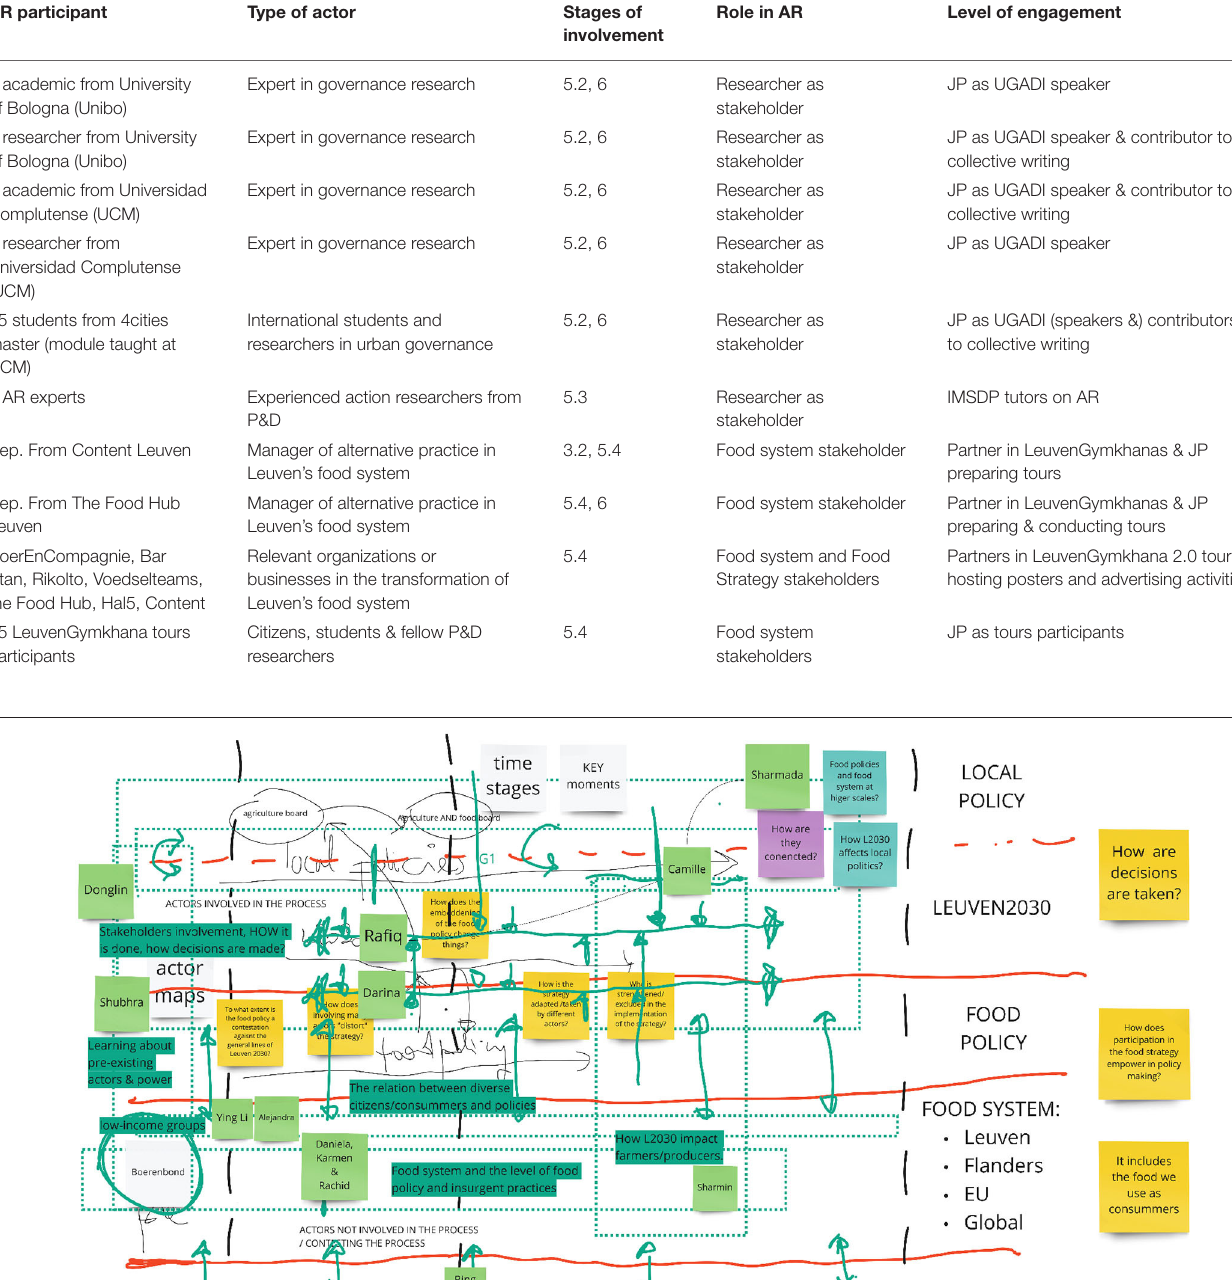
Frontiers in Sustainable Food Systems |